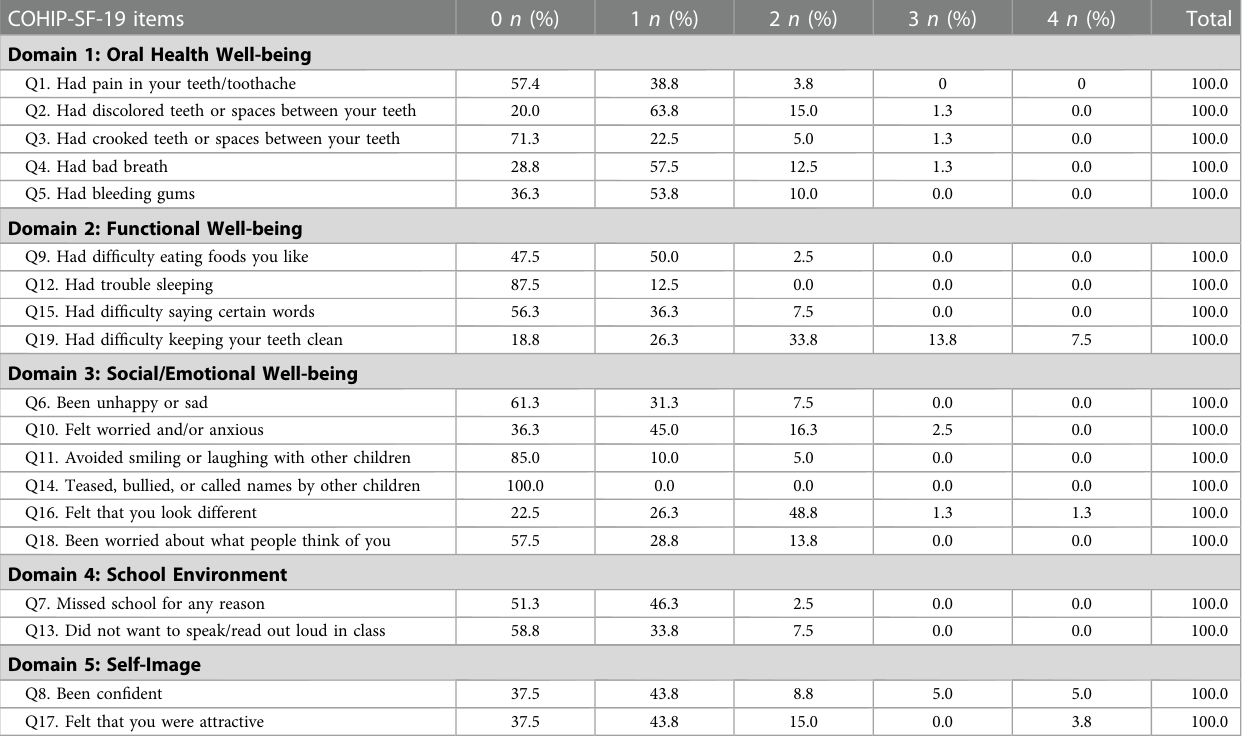
COHIP-SF-19 items